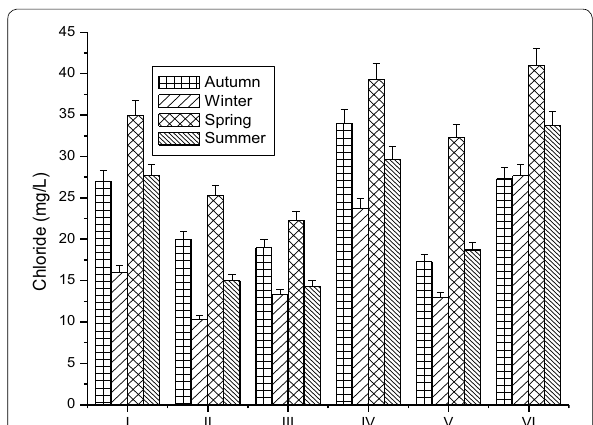
Fig. 13 Spatial and temporal variations of chloride (mg/L) in Hokersar wetland during September 2012–August 2013